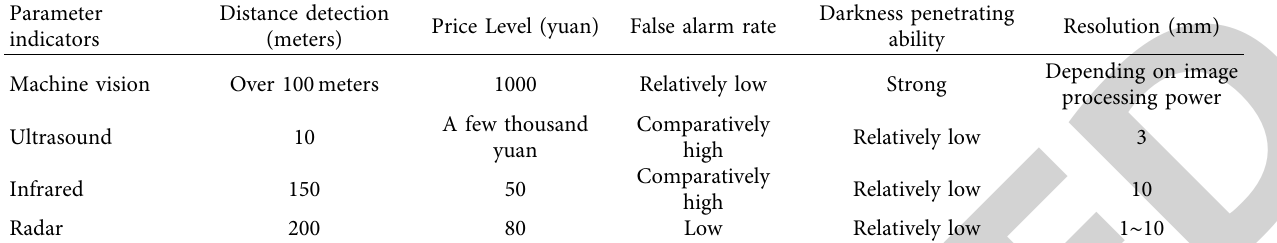
Table 1: Comparison of various sensor performance.